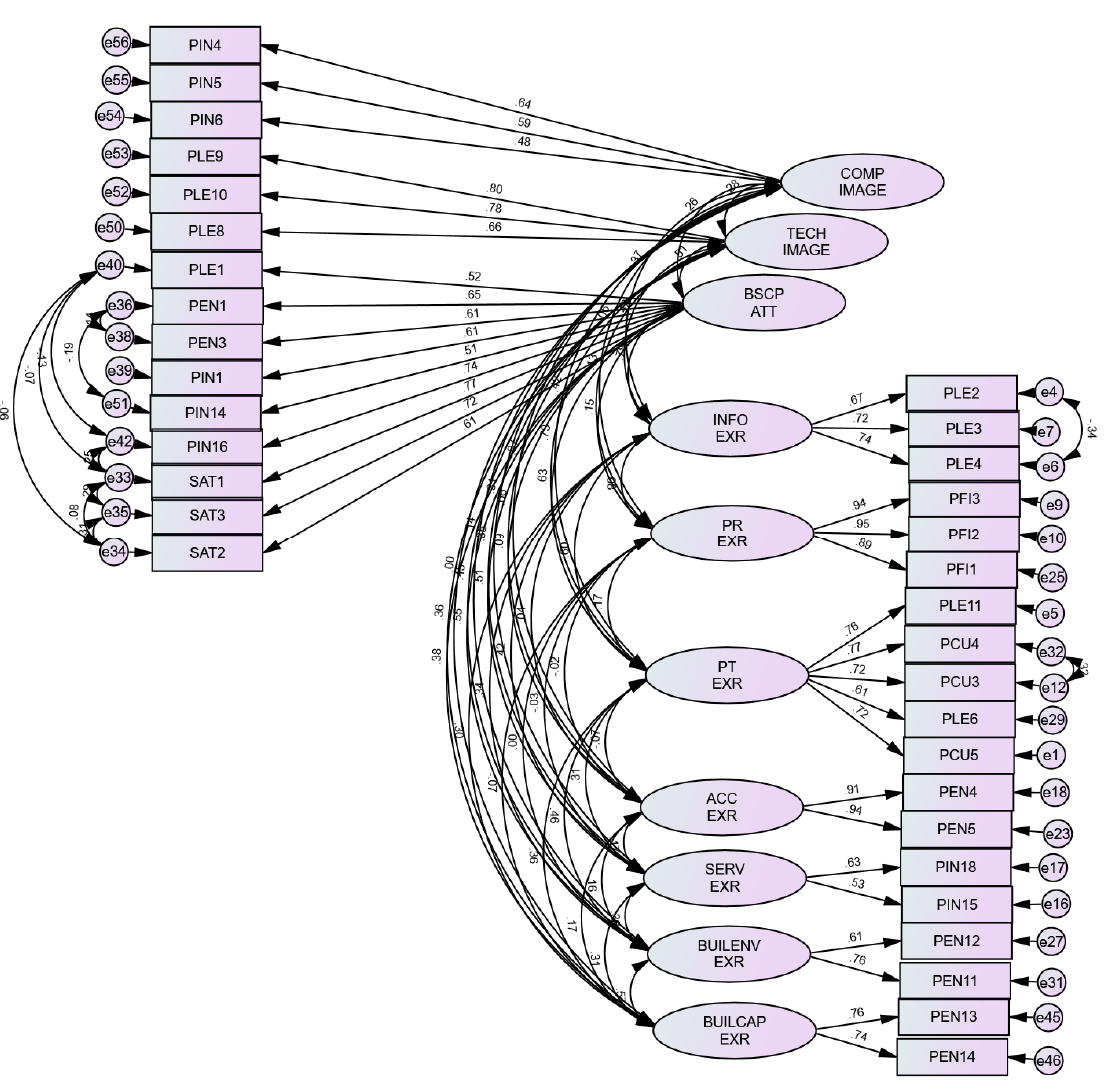
Figure 6. Confirmatory factor analysis (CFA). Independent items on the right side and dependent items on the left side. Note: COMP IMAGE, complications perceived image; TECH IMAGE, technology perceived image; BSCP ATT, patient attitude toward balanced scorecard perspectives; INFO EXR, information experience; PR EXR, price experience; PT EXR, patient experience; ACC EXR, access experience; SERV EXR, services experience; BUILENV EXR, building environment experience; BUILCAP EXR, building capacity experience.